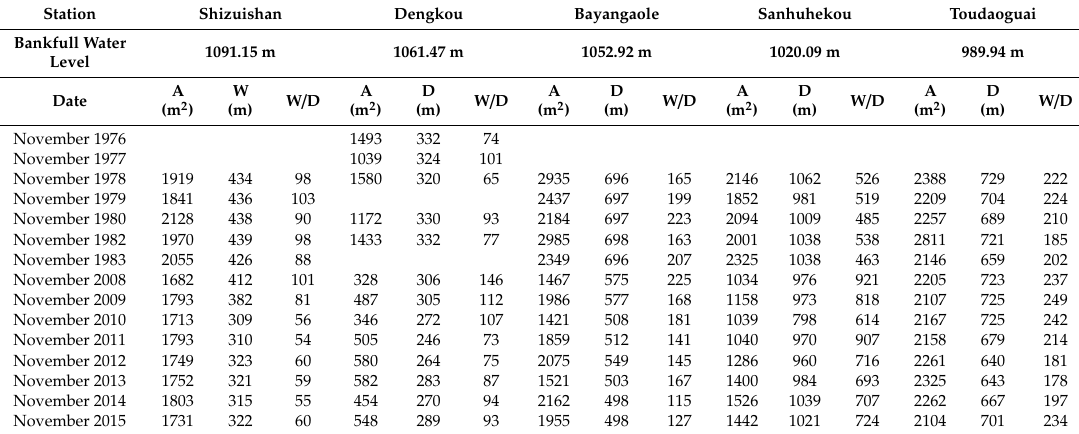
Table 3. Geometrical parameters of the cross-sections at the bankfull levels at the five stations before the ice jam flooding